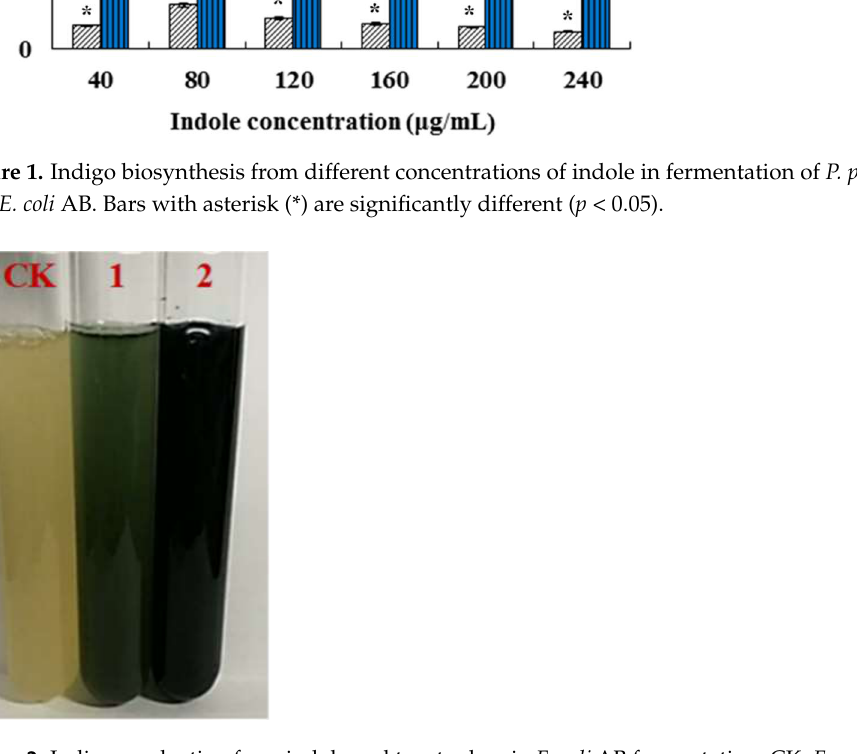
Figure 1. Indigo biosynthesis from different concentrations of indole in fermentation of P. putida B4 and E. coli AB. Bars with asterisk (*) are significantly different ( p < 0.05).